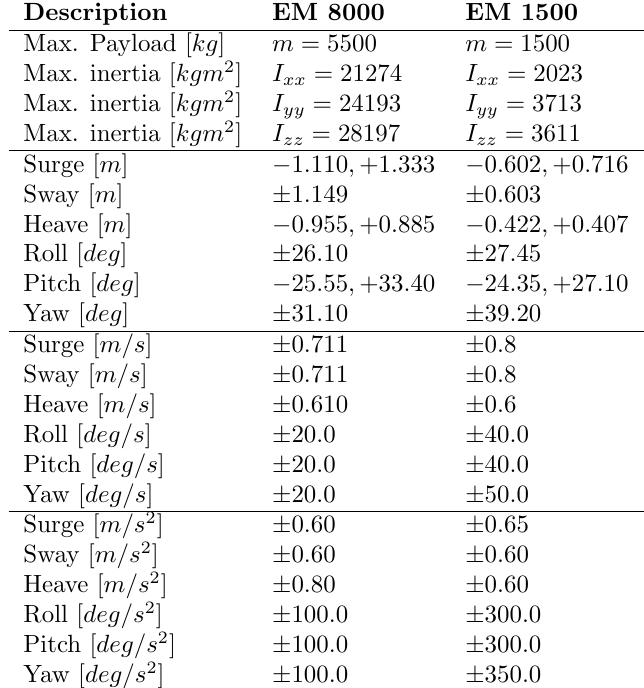
Table 6: Comau SMART 5 - Technical Specification